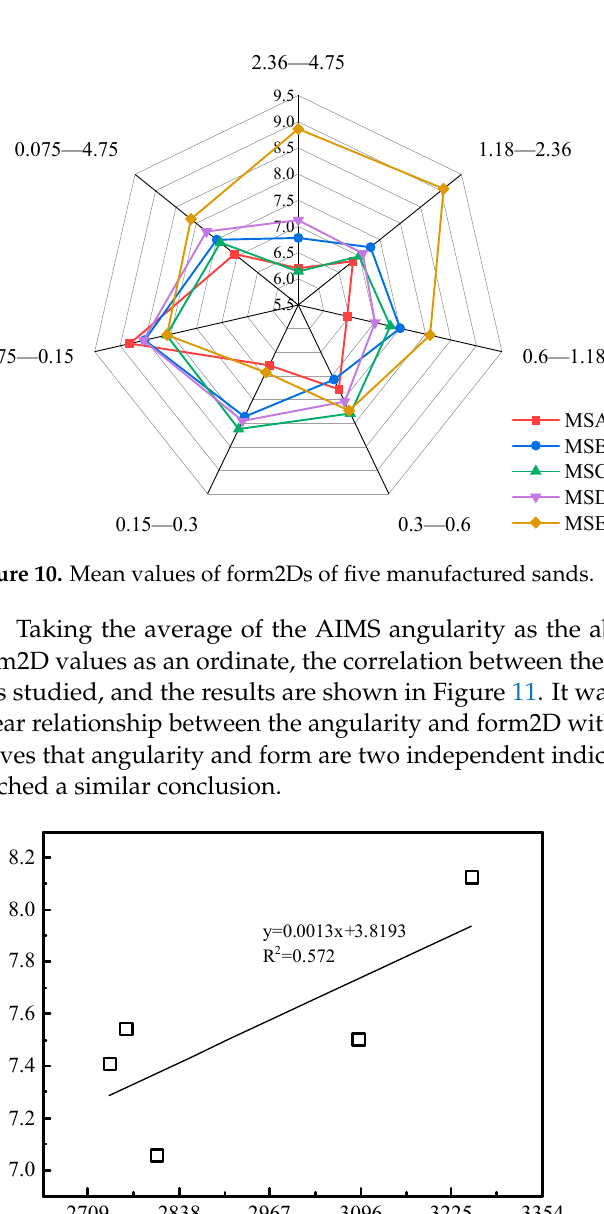
Figure 12. Example of the 20 projections imaged from MSA. 0 ( b ) Figure 13. Variations in the parameters measured for the 20 projections of MSA: ( a ) changes in pa- rameters about acquisition direction ( b ) and boxplot showing the variability of the size parameters.